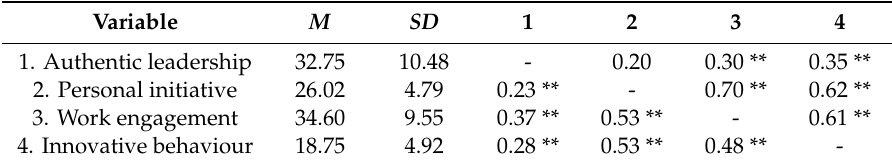
Table 2. Descriptive statistics and correlations between the study variables among employees from the three countries. Variable M SD